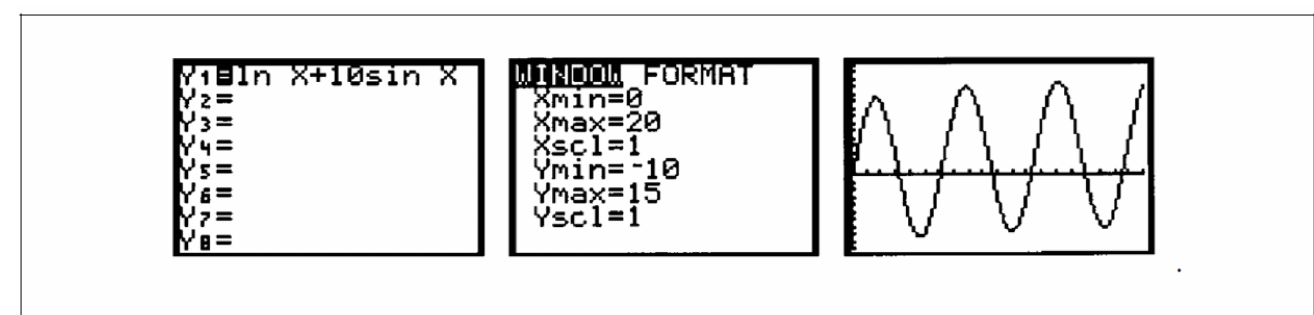
Figure 2. The influence of graphic calculators on mathematical conceptualization.